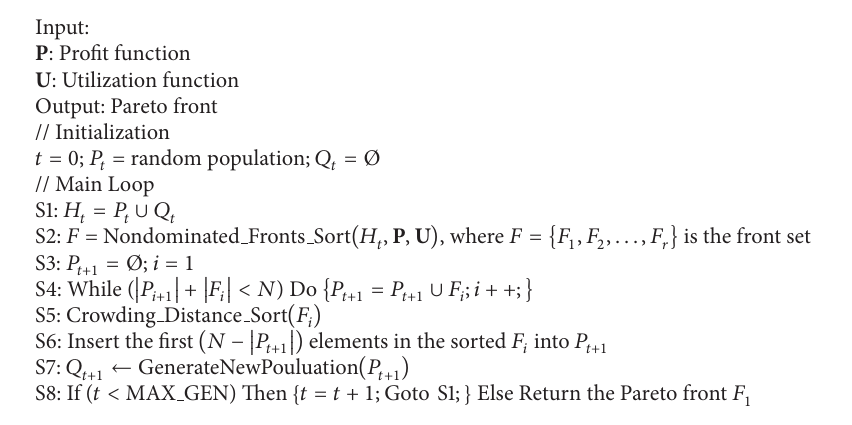
Table 1: Parameter